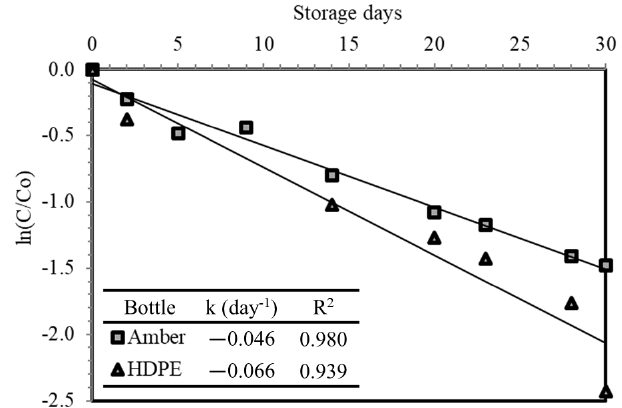
Figure 7. FC decay during the 30-day storage period.